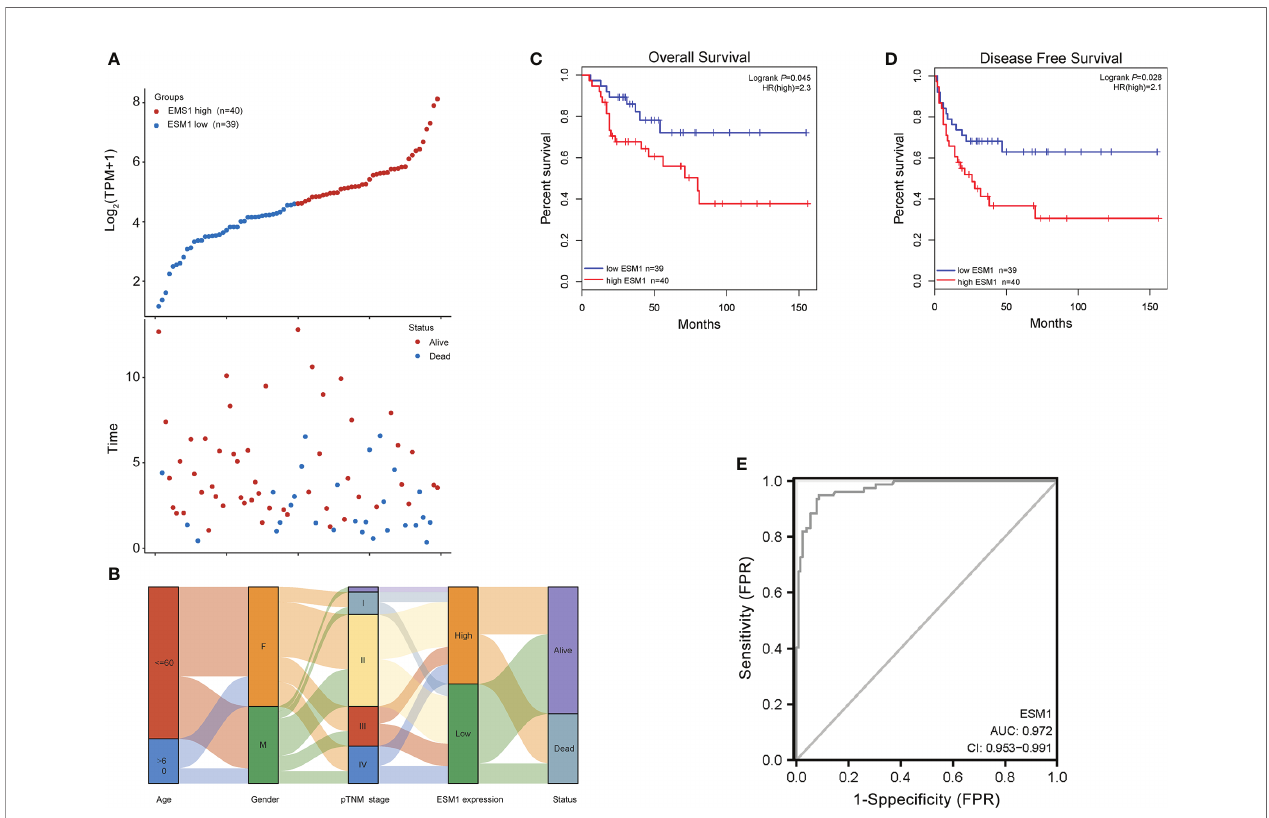
FIGURE 3 | Prognosis analysis of ESM1 in clinicopathological parameters for ACC patients. (A) ESM1 expression (high or low) and survival status (alive or dead) of ACC patients. The top part denotes the scatter plot of the ESM1 expression (low to high); the bottom part means the scatter plot distribution of survival time and survival status corresponding to gene expression of each sample; all the sample order is consistent. (B) Sanguini diagram for depicting the distribution of ESM1 expression in age, gender, pTNM stage, and survival status. Each column displays a feature variable, different colors represent different types or stages, and lines represent the distribution of the same sample in different feature variables. The OS (C) and PFS (D) for patients with high (red) and low (blue) ESM1 expression in ACC at the threshold of p -value <0.05. (E) ROC curves of ESM1 expression in ACC. The area value under the ROC curve is between 0.5 and 1. The closer the AUC is to 1, the better the diagnostic effect. AUC has certain accuracy when it is 0.7~0.9, and higher accuracy when AUC is above 0.9. FPR, false-positive rate; TPR, true-positive rate.